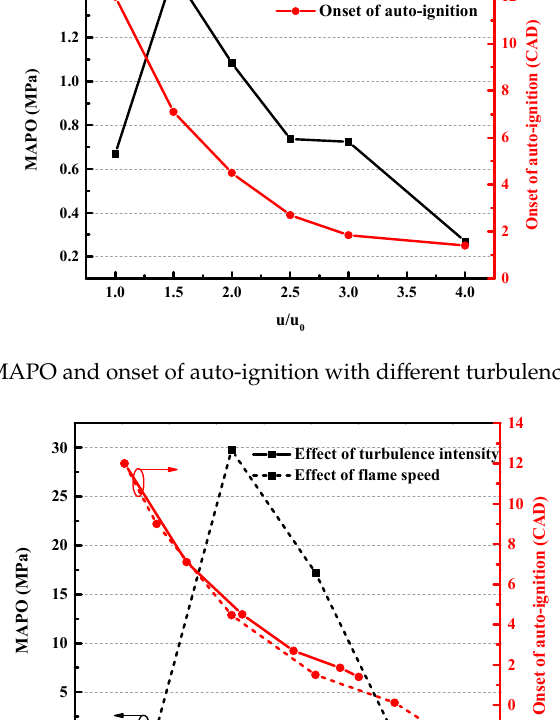
Figure 15. Pressure traces and filtered pressure oscillations with different turbulence intensities.